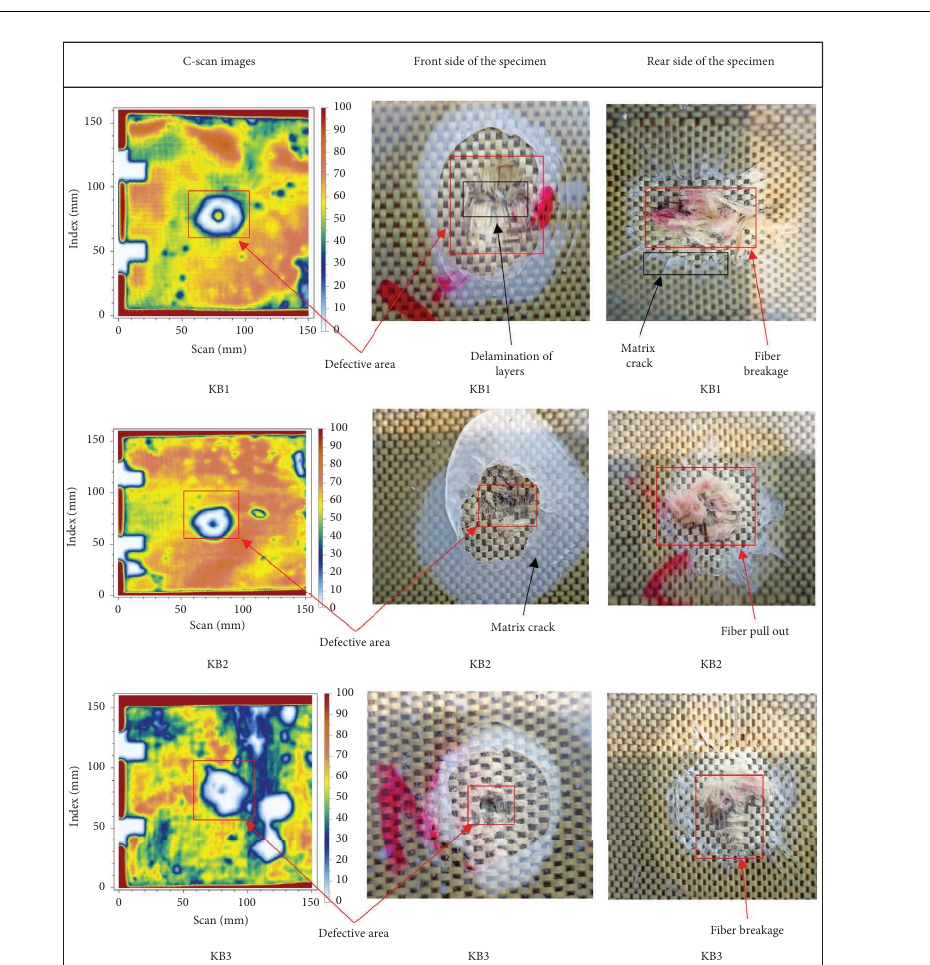
Figure 13: Impact strength vs. composite material. Table 6: C-scan, front and back side images of all the